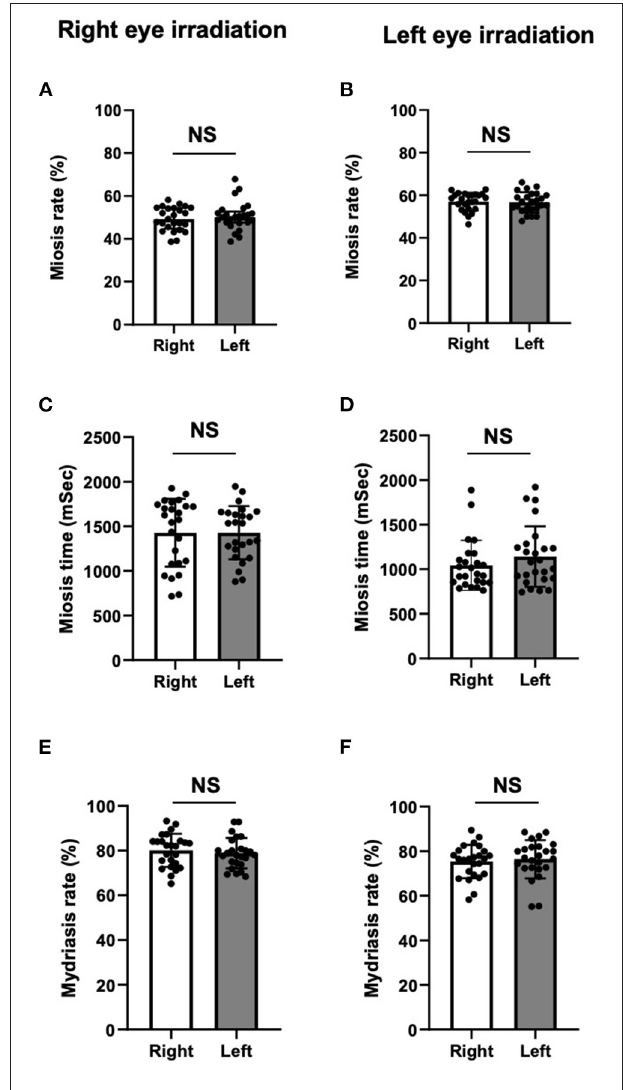
FIGURE 3 | Miosis rates (A,B) , miosis times (C,D) , and mydriasis rates (E,F) in healthy volunteers. There were no significant differences in miosis rate (A,B) , miosis time (C,D) , and mydriasis rate (E,F) in both right and left pupils between direct and indirect irradiation. For all panels, Data are presented as the mean ± SD. Closed circles show data distribution. NS, not significant. N =